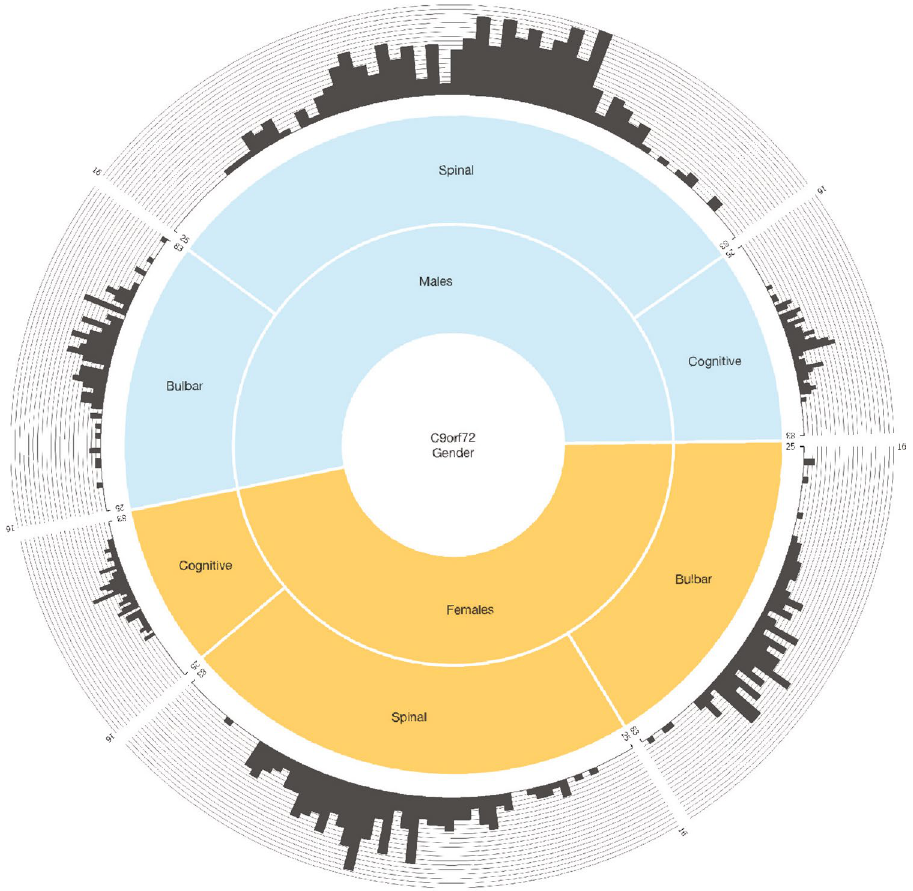
Figure 1. Relationship between gender and site of onset in C9orf72 repeat expansion carriers. Donut chart showing the site of symptom onset and age at onset among male and female C9orf72 carriers. Inner layer shows the proportion of males (52.6%) and females (47.4%) in the cohort. The middle layer shows the site of onset within males and females. The outer histogram layer shows the age distribution within each subset. The y-axis of this outer histogram represents the number of patients at each age, whereas the x-axis represents age at symptom onset ranging from 25 to 83 years of age. The graph was created using Circos (version 0.67, available at www.circos.ca) and FusionCharts